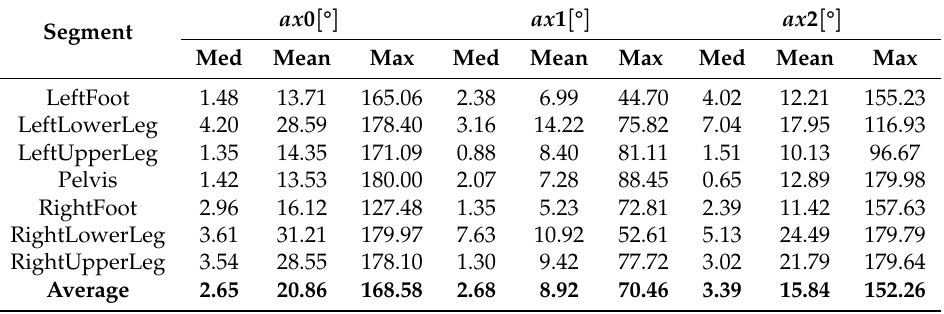
Figure A11. I2S assignment problem, final model: test person from dataset C , IMU configuration according to Figure 8). Average accuracy: 99.14%. Table A10. I2S alignment problem, final model, all test persons and IMU configurations: median, mean and maximum angle errors around the three body segment